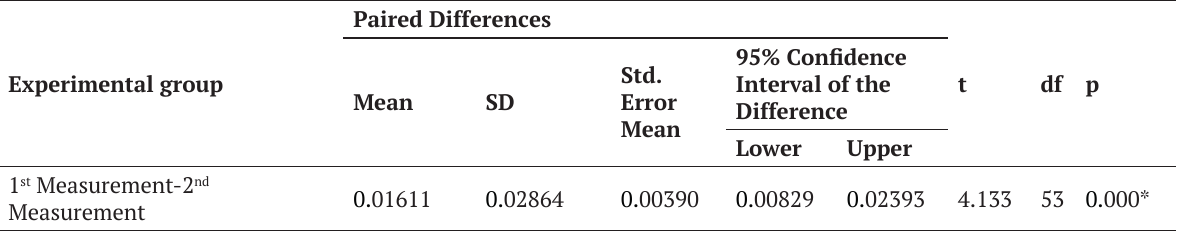
Table 5. The analysis results between the 1st and 2nd measurement values of the experimental group (Paired Samples test)